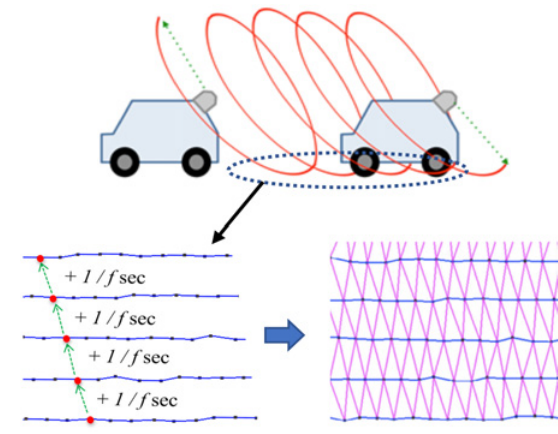
Figure 6. Conversion to wireframe